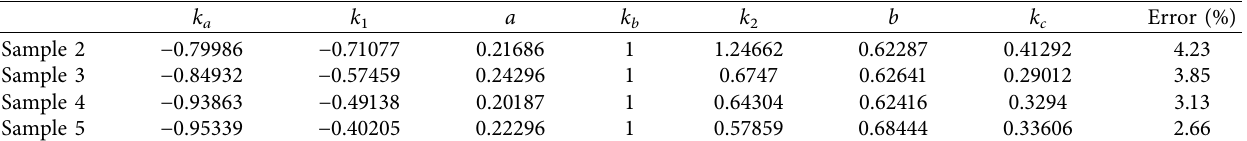
Figure 13: Fitted 3D graph of sample 5. (a) Fitted 3D graph of the 0 ° incident angle; (b) fitted 3D graph of the 30 ° incident angle; (c) fitted 3D graph of the 45 ° incident angle; (d) fitted 3D graph of the 60 ° incident angle. Table 1: Model parameters and errors of sample 2 to sample 5 when the incident angle is 60 °